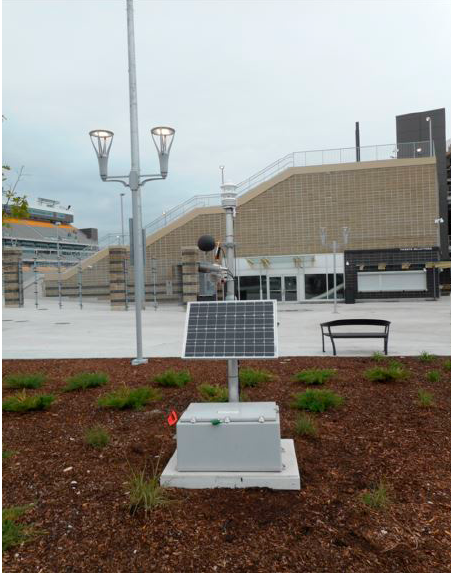
Figure 1. Hamilton Soccer Center mesonet station used to monitor environmental conditions during the PA15 Games’ soccer events. Source: Environment and Climate Change Canada.